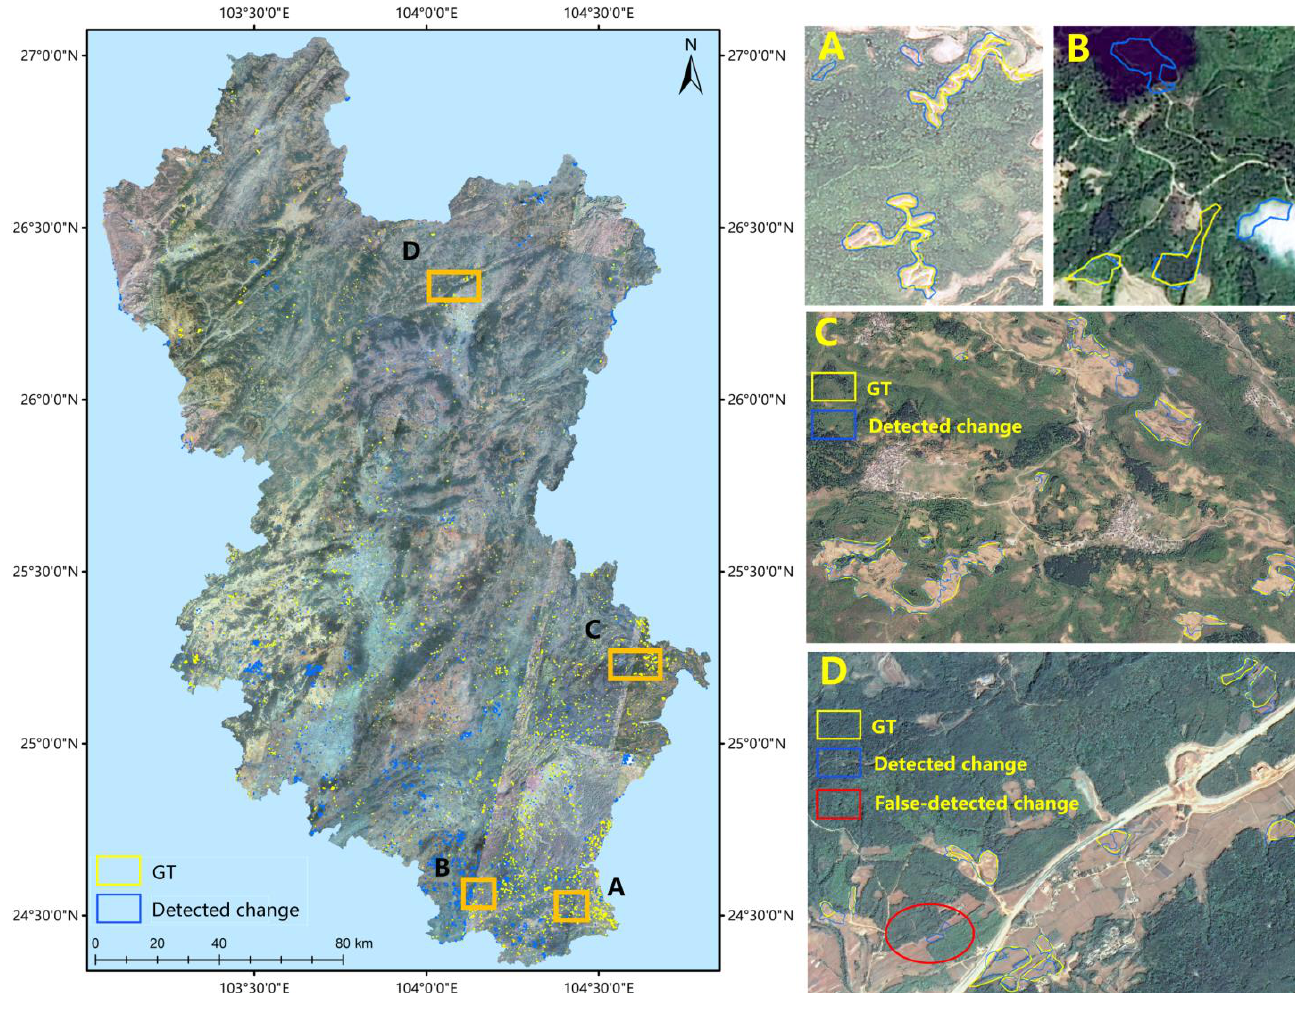
Figure 8. Deforestation detection for Qujing City.